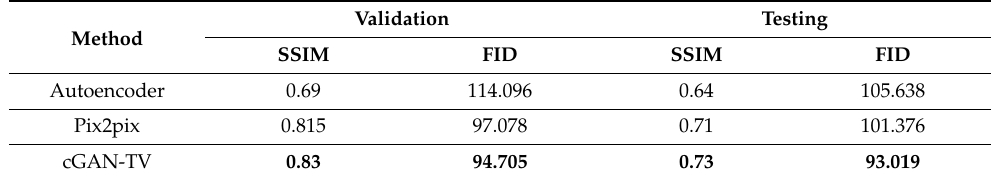
Table 6. SSIM and FID comparison between cGAN-TV and other